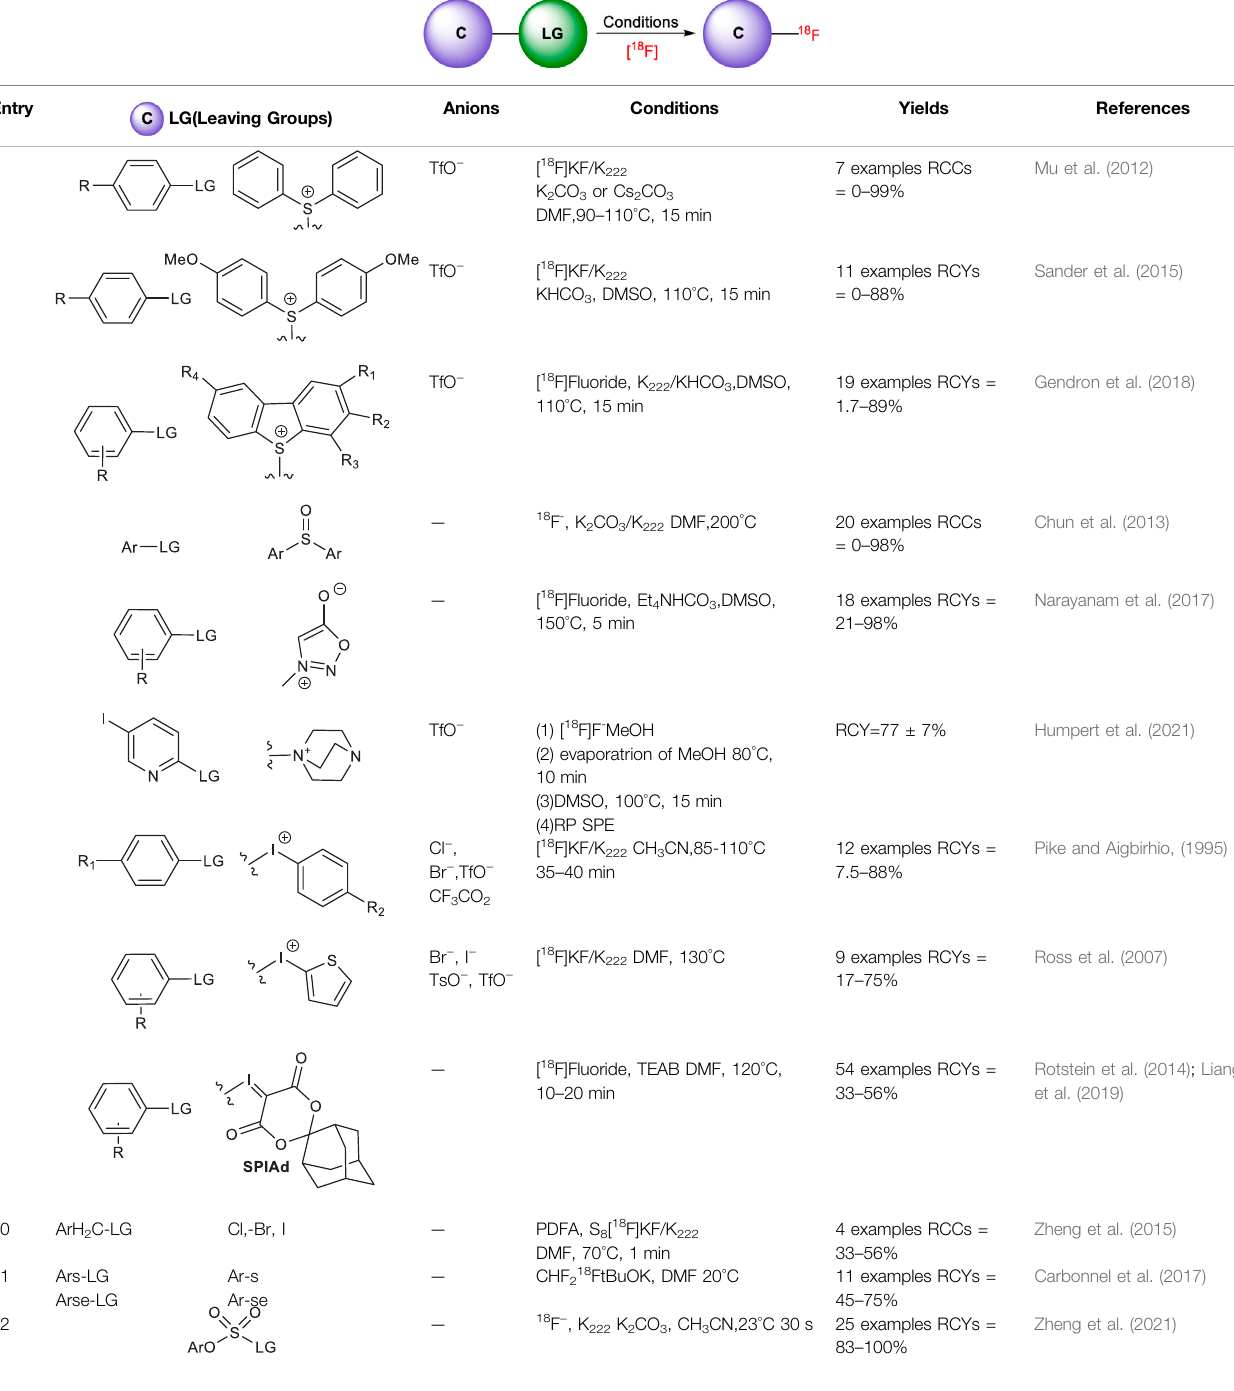
TABLE 1 | Non-catalytic labelling reactions of substrates with good leaving